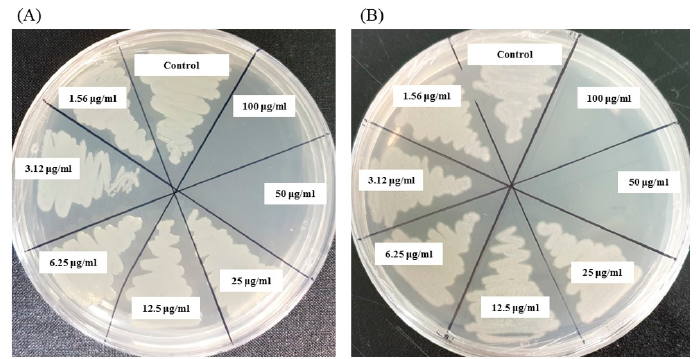
Figure 10. MBC of synthesized AgNPs against E. coli ( A ) and P. aeruginosa ( B ).